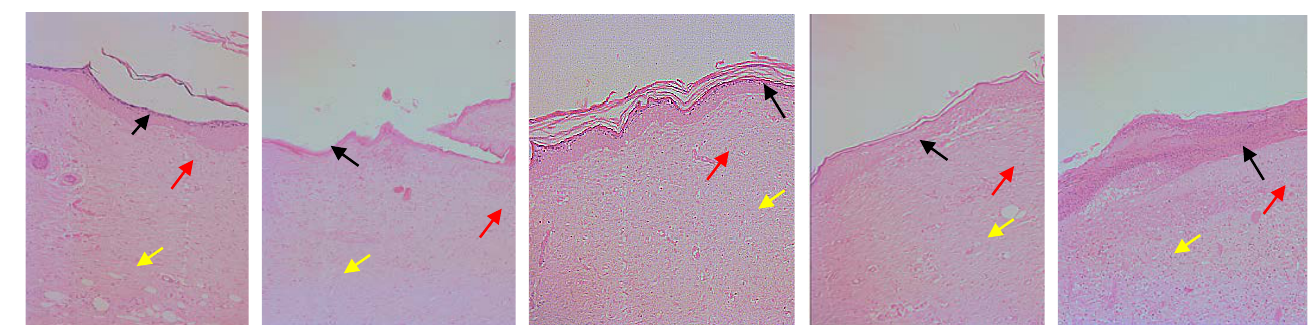
Figure 5. Histology of skin from diabetic animals infected with MRSA stained with H & E stain (100×) . Photomicrographs showing regenerated epithelium in different groups. Black arrows show epidermis, yellow arrow shows capillaries, and red arrow shows inflammatory cells. In normal animals, the height of the epidermis is high, with a number of capillaries and few inflammatory cells. In infected animals, the epidermal height was noticeably less, with fewer capillaries and more inflammatory cells. The epithelial height, capillaries and the number of inflammatory cells were more in the M. oleifera - and mupirocin-treated animals. M.O = M. oleifera leaf extract formulation, MUP = mupirocin (2% w / w ).